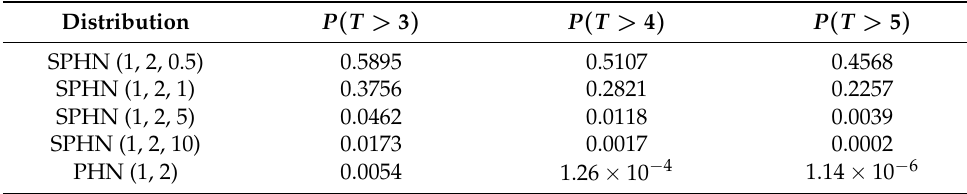
Table 1. Right tail comparison for different SPHN and PHN